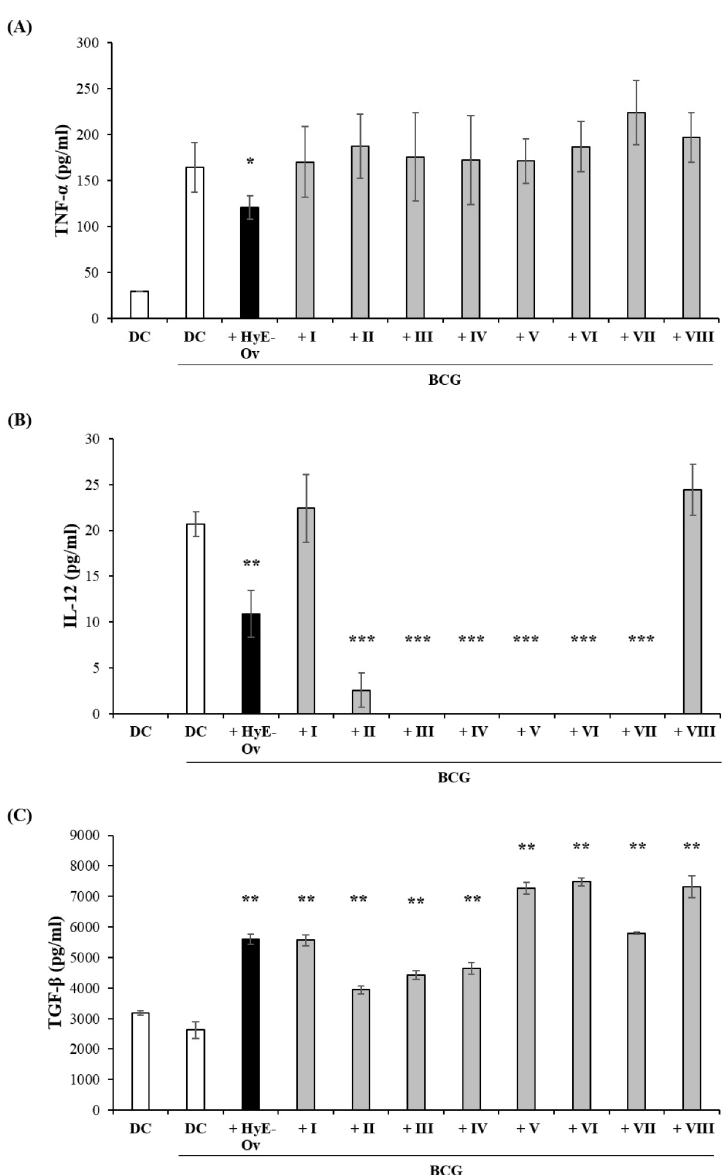
Fig 8. Effects of fractions from HyE-Ov on inflammatory response. DC (10 6 /well) were infected with BCG (MOI 5) for 3 hours and then stimulated or not with HyE-Ov or with eight HyE-Ov derived fractions. At 72 hours after stimulation, supernatants were collected, stored at -20˚C and then analysed by ELISA. Data are expressed as means ± SD of culture triplicate and are representative of 2 independent experiments performed on cells from different donors. � p < 0.05, �� p < 0.01 and ��� p < 0.0001 in comparison with non-stimulated infected